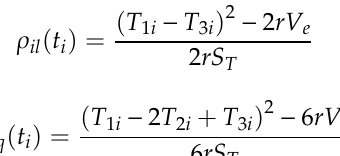
table. V e is the error variance. T 1 i , T 2 i and T 3 i are the sub-sum of the experiment results y corresponding to 3 levels of x i . r is repetition number of the same level in the orthogonal